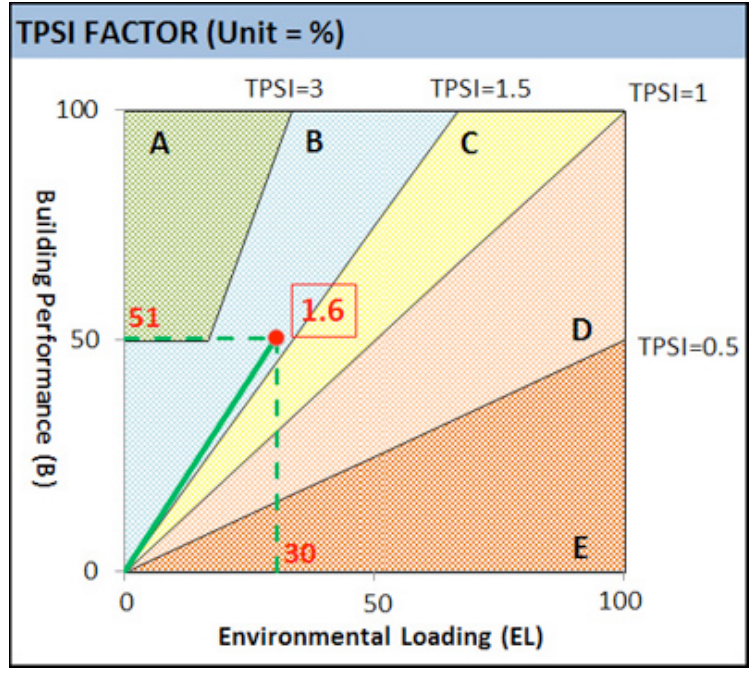
Figure 3. A sample calculation of TPSI Factor.